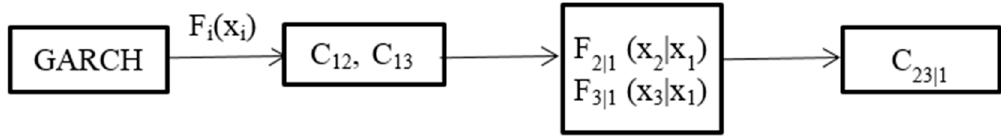
Figure 15. Estimation processes of parameters initial values.